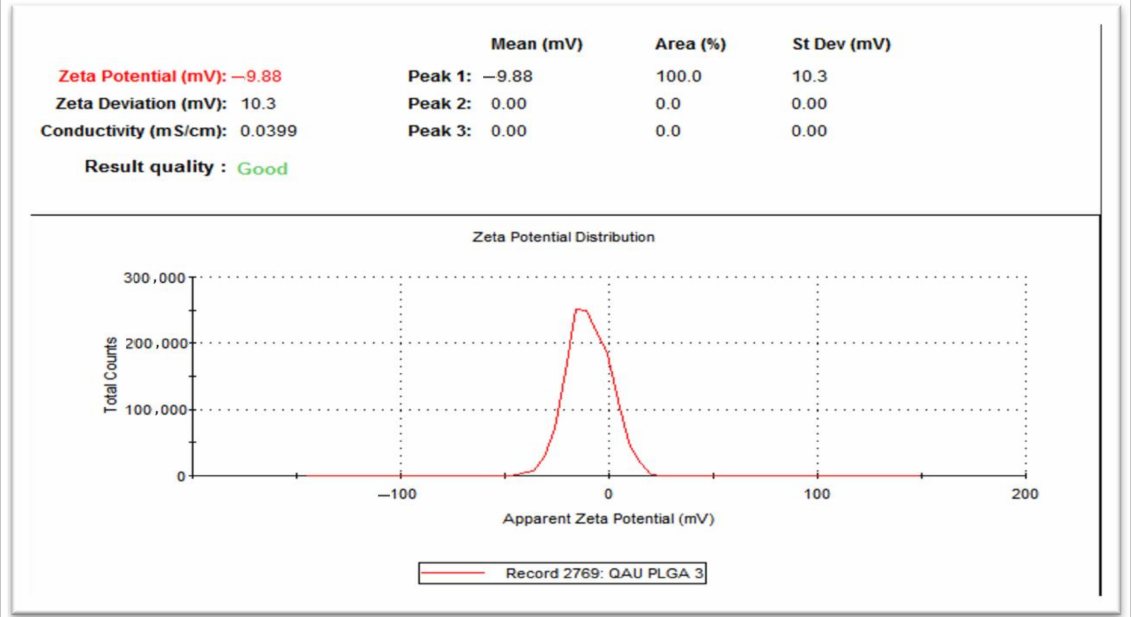
Figure 2. Dynamic light scattering results for particle size and size distribution: ( a ) Blank PLGA NPs and ( b , c ) RIS-loaded NPs.